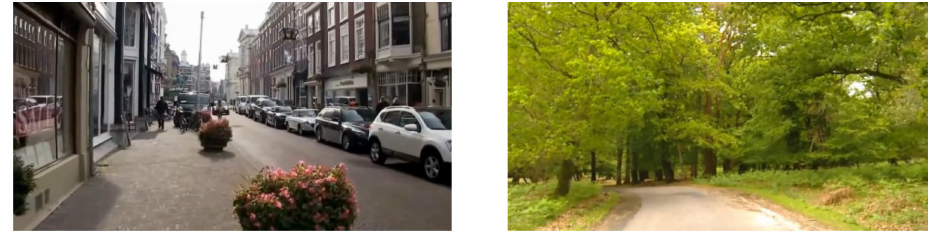
Figure 1. Screenshots of the two environmental conditions, built ( left ) and nature ( right